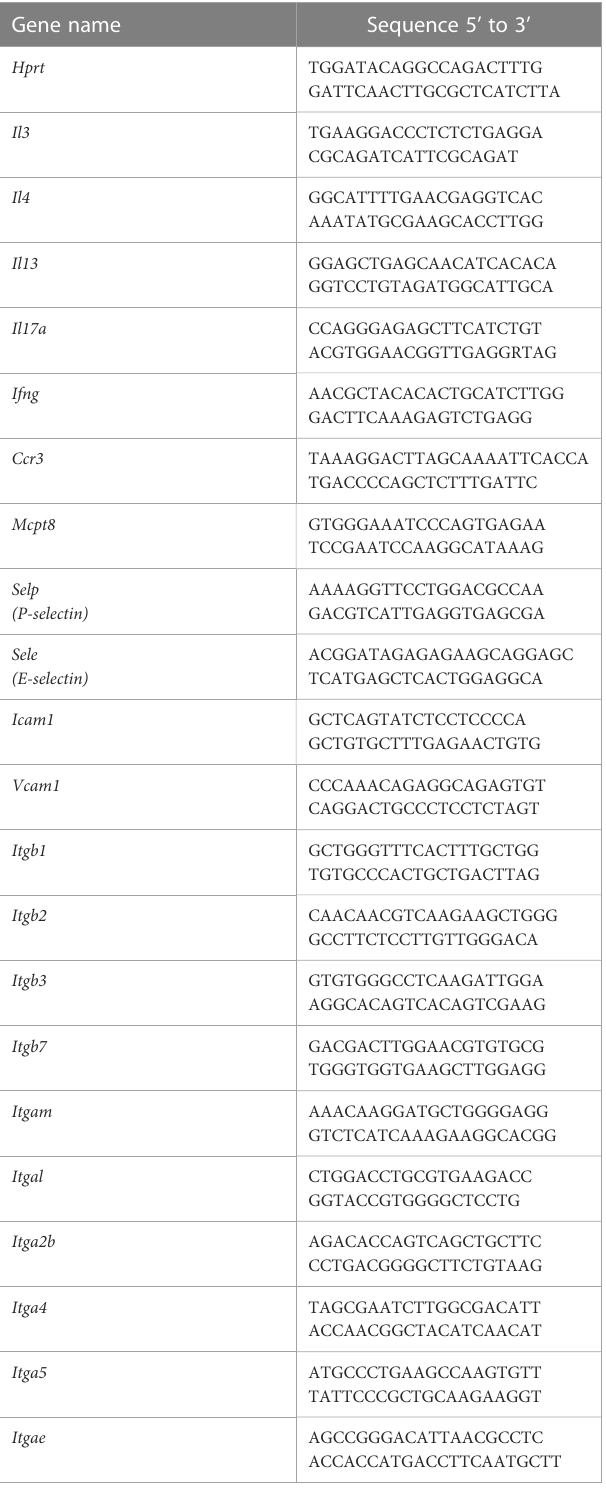
TABLE 2 Sequences of PCR primers for mouse genes. TABLE 3 Sequences of PCR primers for human